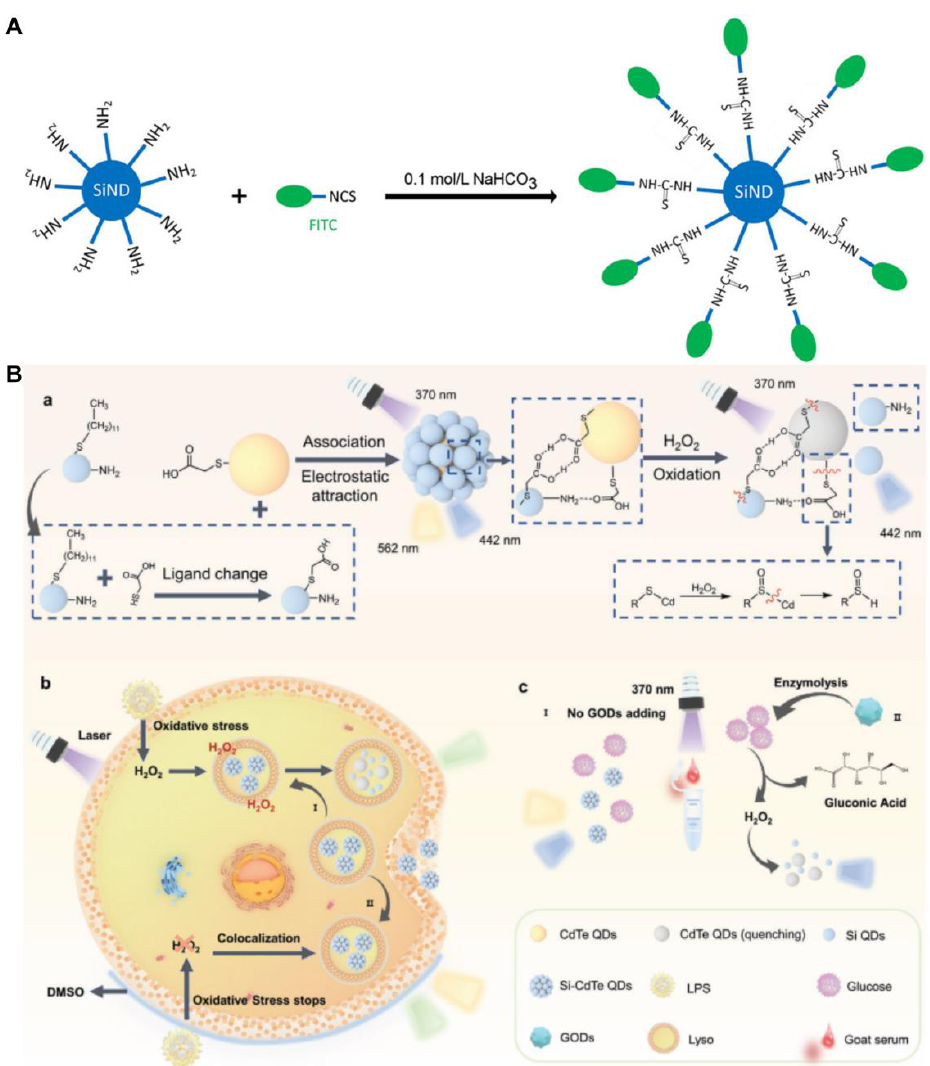
Figure 5. ( A ) Schematic of the ratiometric pH sensor: FITC-modified SiQD. Reproduced from [69], with permission from Elsevier, 2020. ( B ) Schematic diagram of (a) the synthesis of a Si-CdTe QDs probe for the detection of (b) H 2 O 2 in cells and (c) glucose in goat serum, respectively. Reproduced from [73], with permission from Willey, 2022.